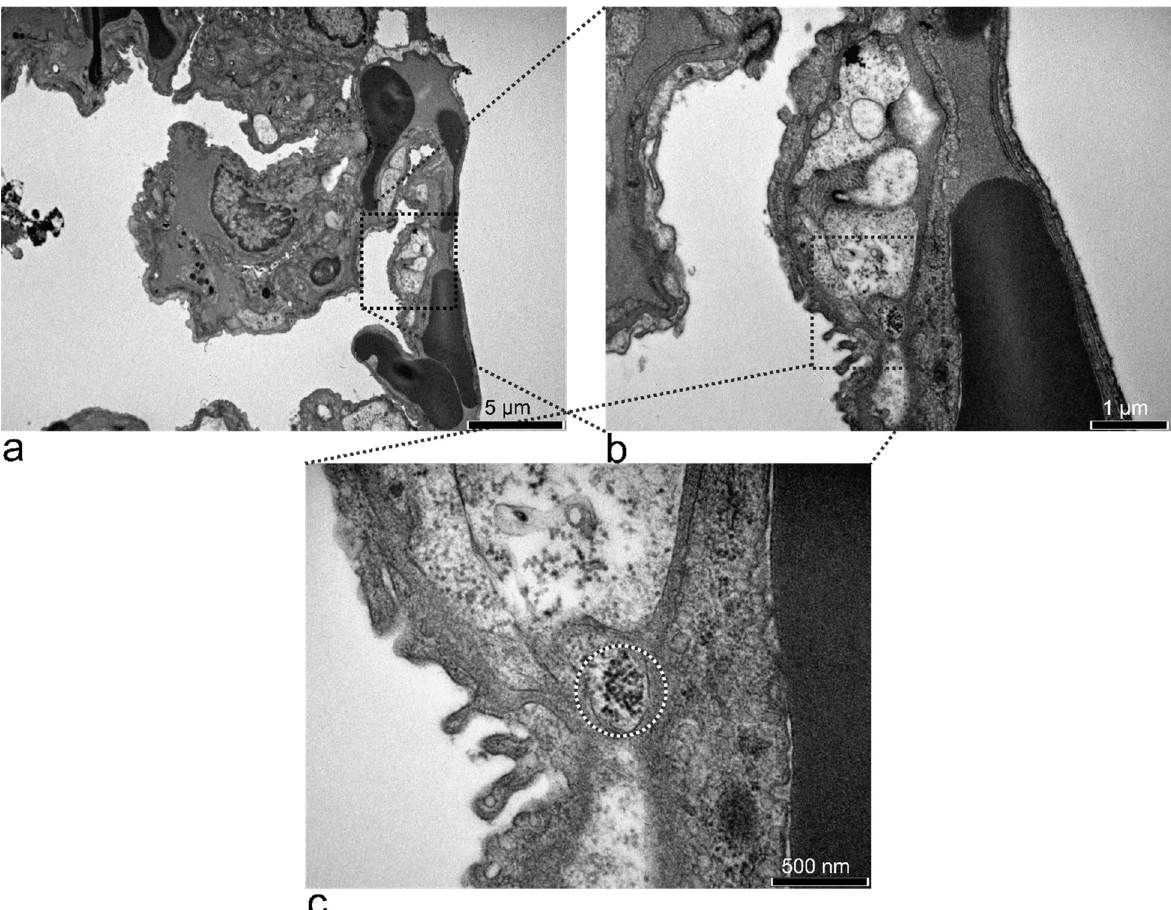
Figure 7. TEM micrographs of the lung treated with SPION-PEG for 15 min ( a ). At a higher magnification, a large vesicle was observed ( b ). The vesicle (black and white circle) had electron-dense particles inside, resembling 10 nm SPIONs ( c ).